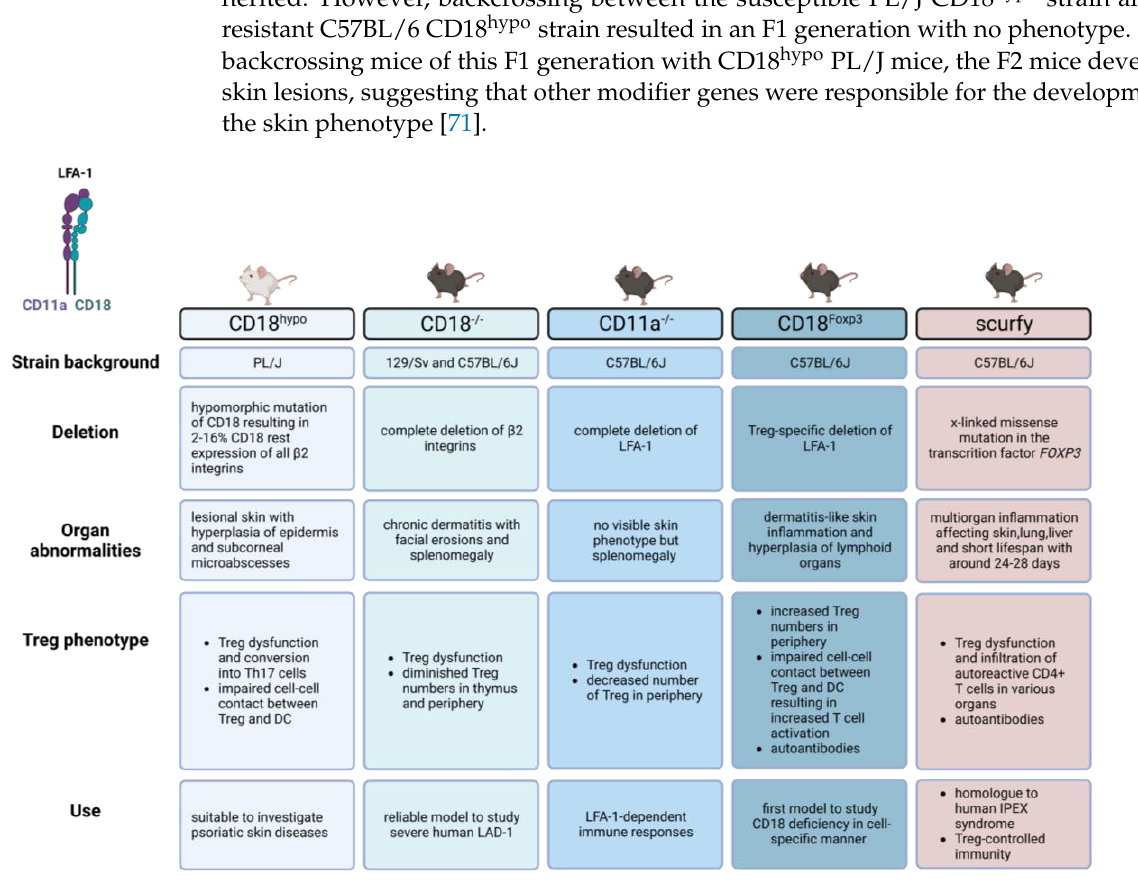
Figure 2. Integrin-deficient mouse models in comparison to foxp3-deficient scurfy mice BioRender.com (accessed on 7 March (created with BioRender.com (accessed on 7 March 2023).